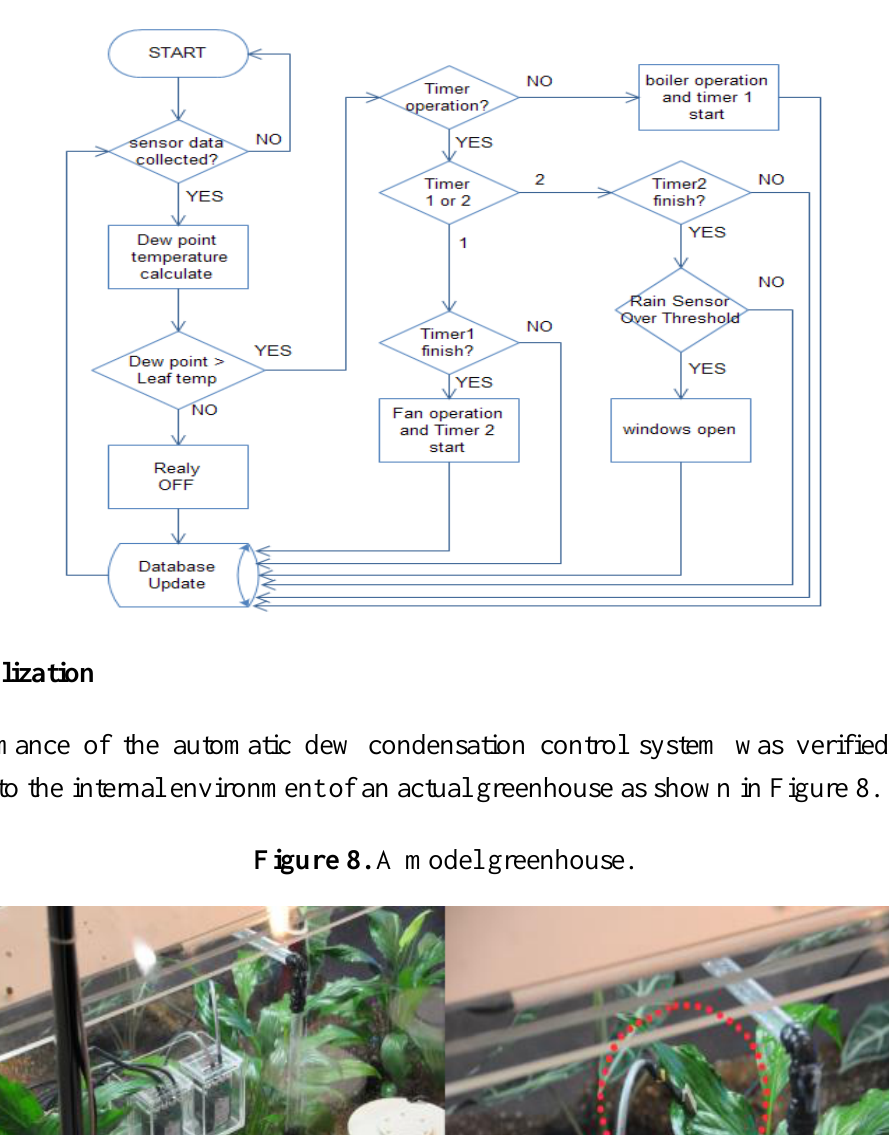
Figure 7. Automatic dew condensation control system